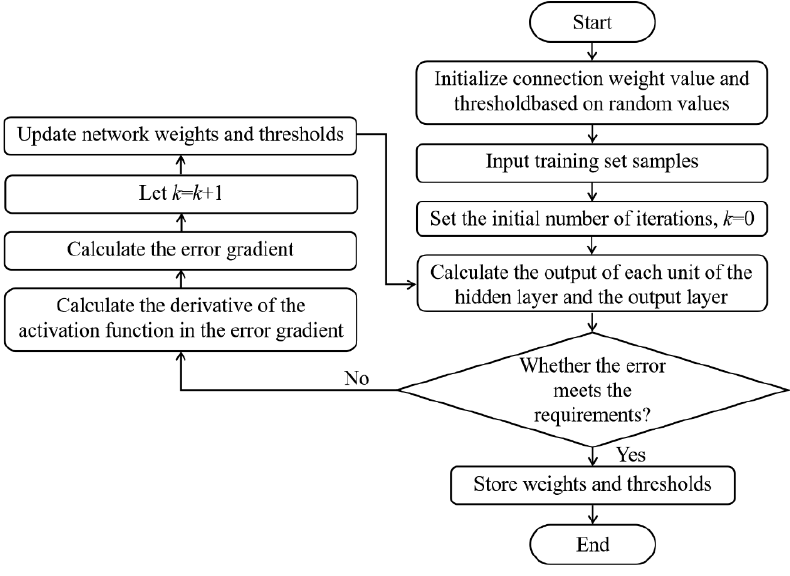
Figure 6. The calculation process chart for the CNN model.